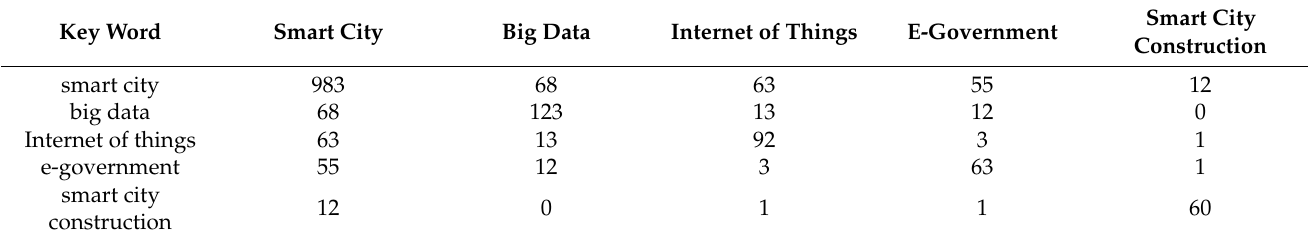
Table 1. High-frequency keyword co-occurrence matrix (part).